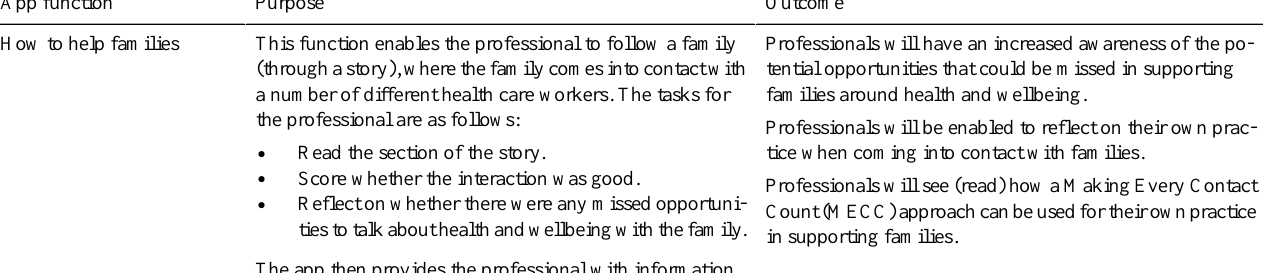
Table 1. NoObesity Professional app functional overview. OutcomePurposeApp